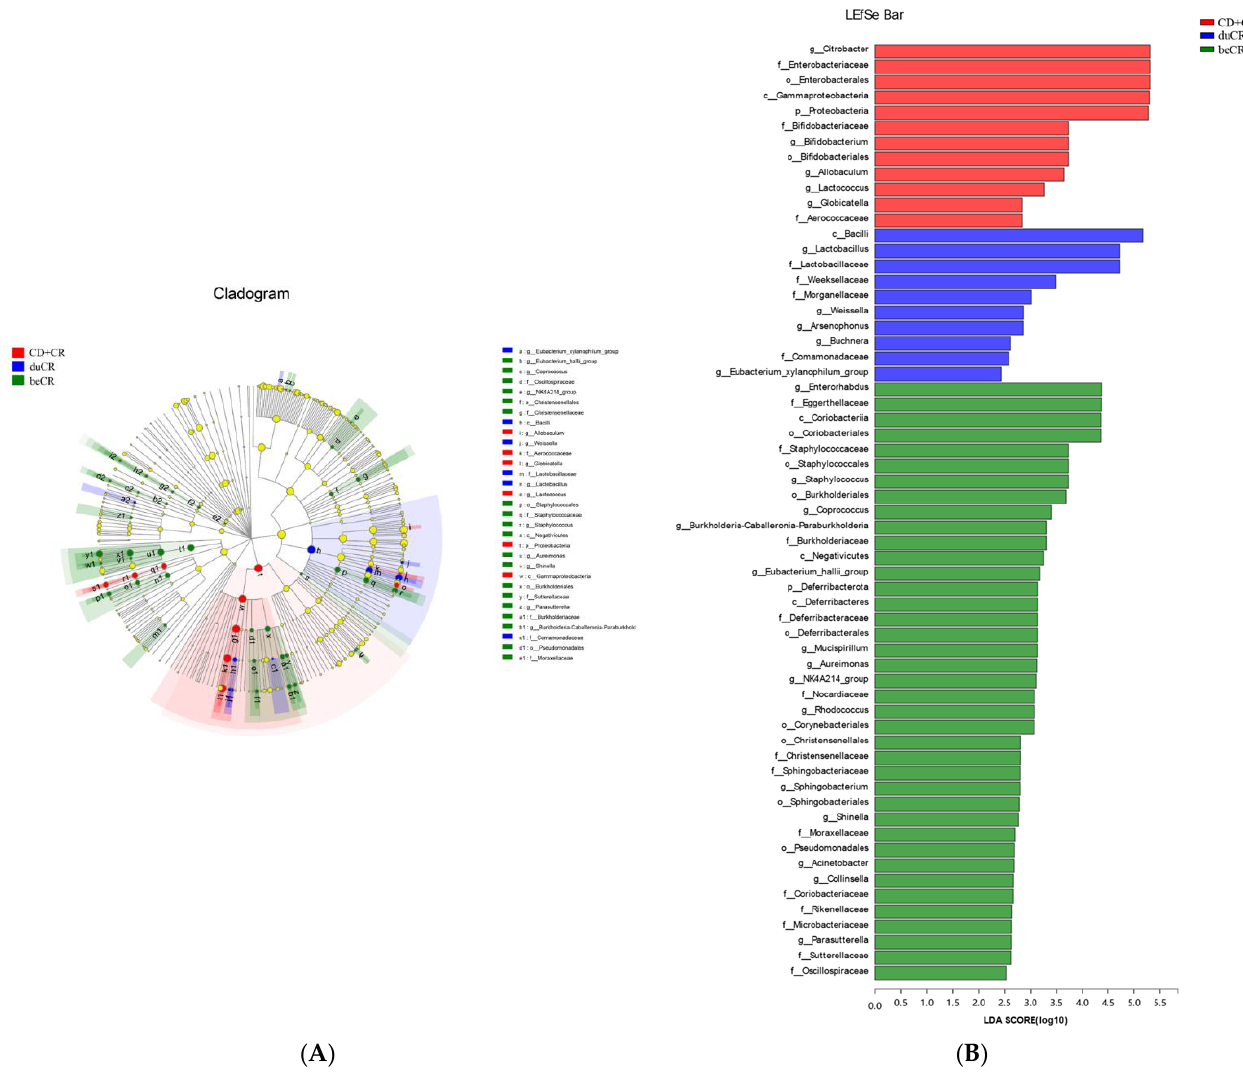
Figure 7. Effect of the beCR and duCR intervention on key microbial phylotypes. ( A ) Cladogram and ( B ) LDA scores derived from LEfSe analysis.